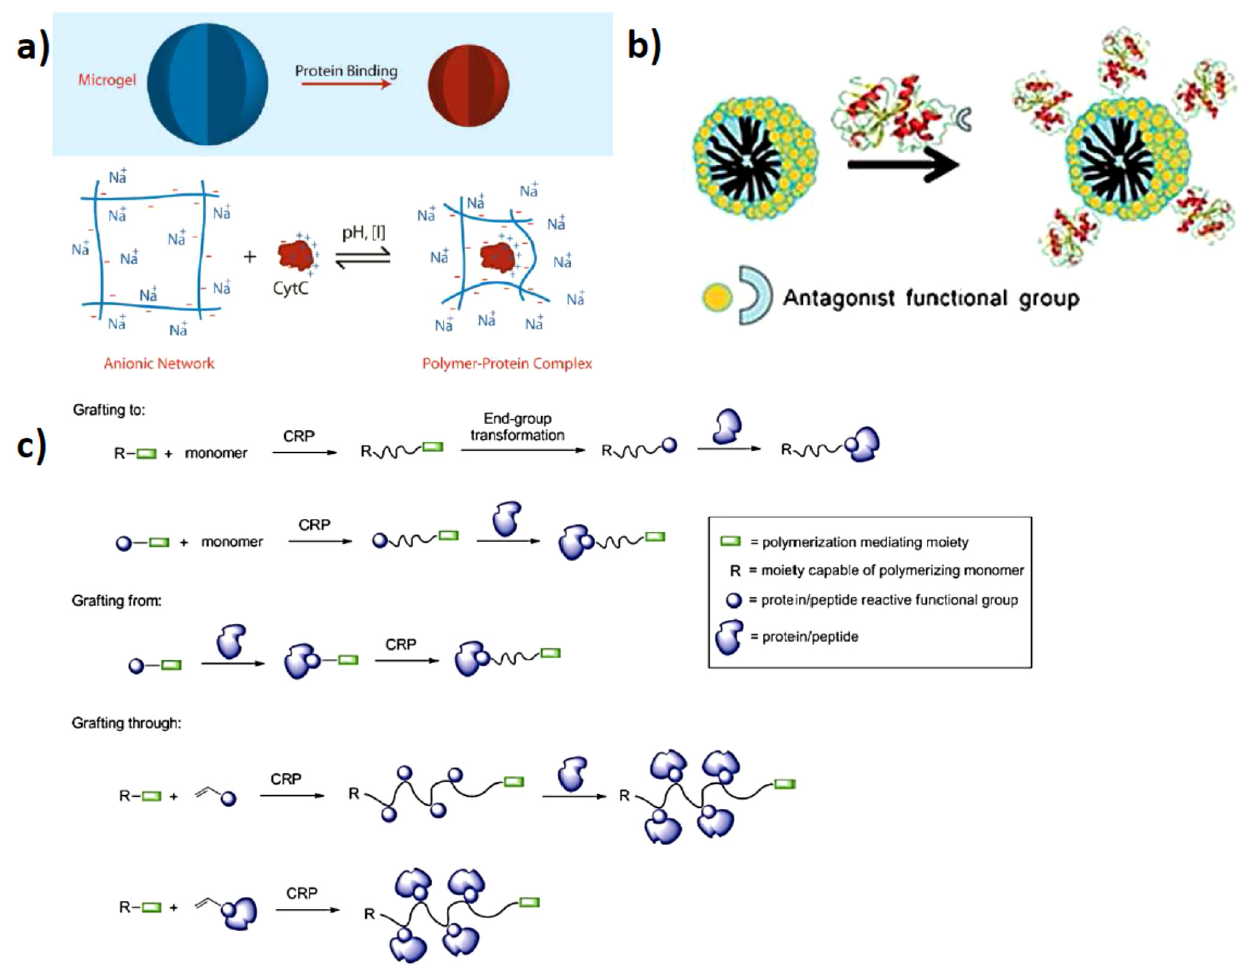
Figure 1. Schematics of ( a ) polymer protein interactions by opposite charges (reprinted with permission from [14]); ( b ) Covalent functionalization of the protein to incorporate specific receptor-like interactions with polymeric systems (reprinted with permission from [15]); ( c ) Covalent attachment to- and growing from the protein surfaces (reprinted with permission from